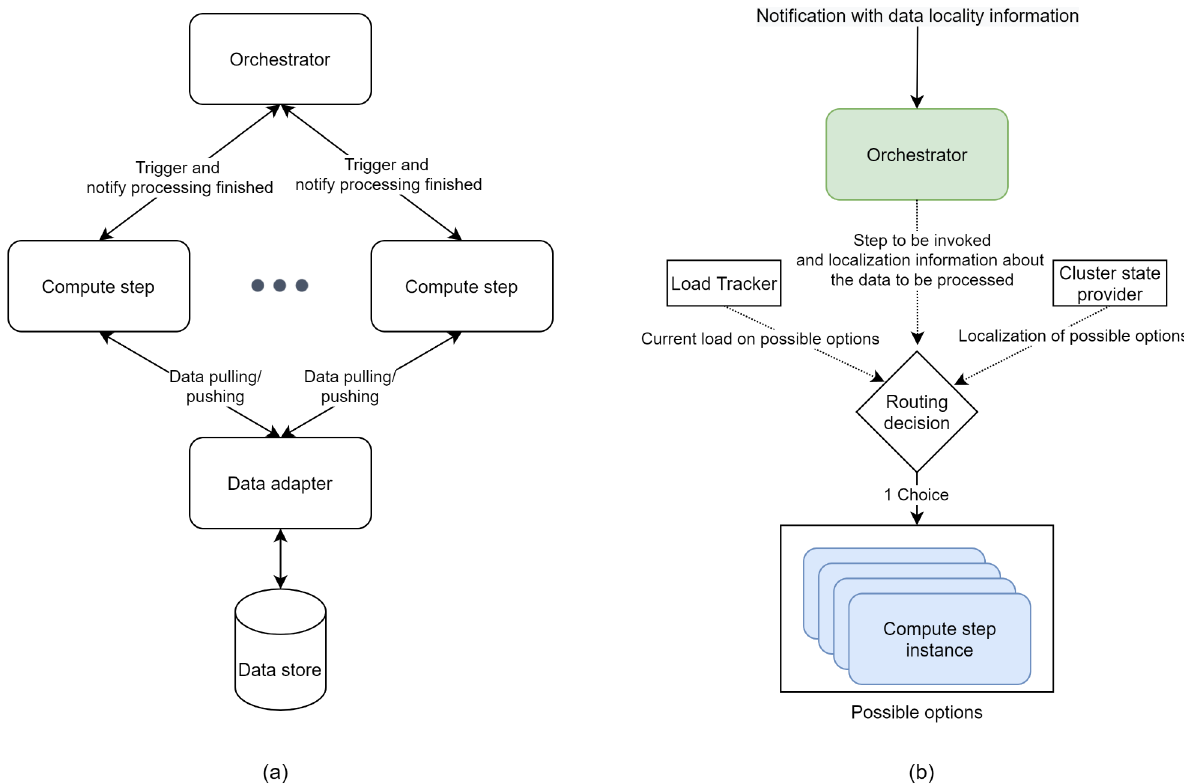
Figure 2. ( a ) Detailed view of a compute step, and ( b ) data locality as a multi-objective optimisation